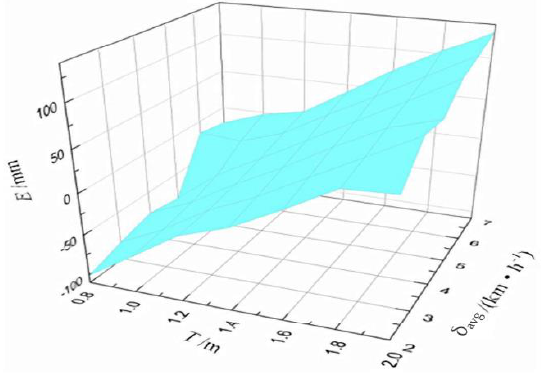
Figure 13. Error curved surface of orthogonal data.